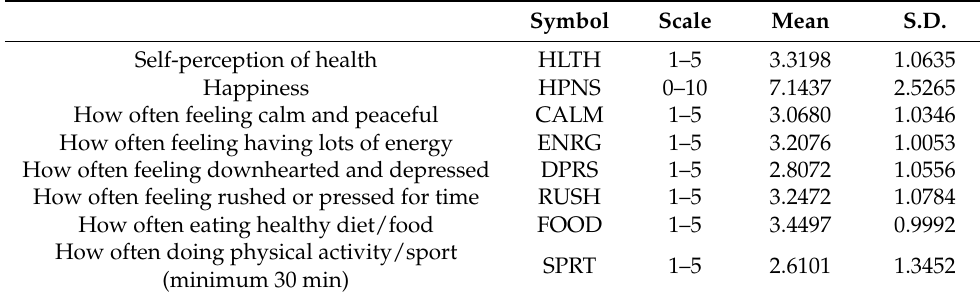
Table 1. Descriptive statistics of variables in the path